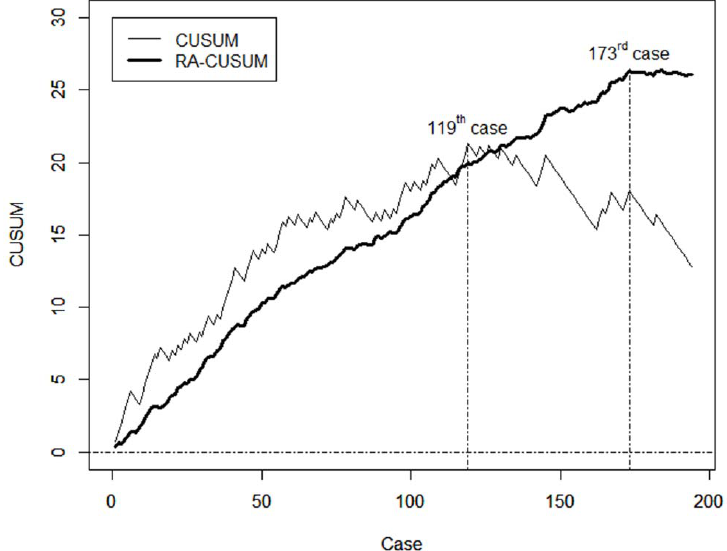
Figure 2. The learning curves for temporary hypoparathyroidism as determined by CUSUM and risk-adjusted CUSUM (RA-CUSUM) analysis.